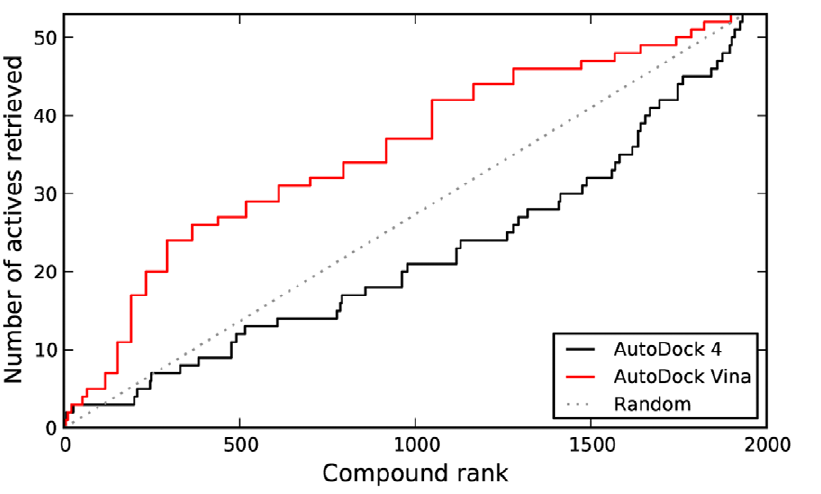
Figure 6. Virtual screen ranking of DUD compounds. The 1,885 DUD compounds were docked to HIV protease using AD4 and Vina, then ranked by predicted binding energy. The plot shows the number of active compounds (as designated by DUD) retrieved versus the total number selected.